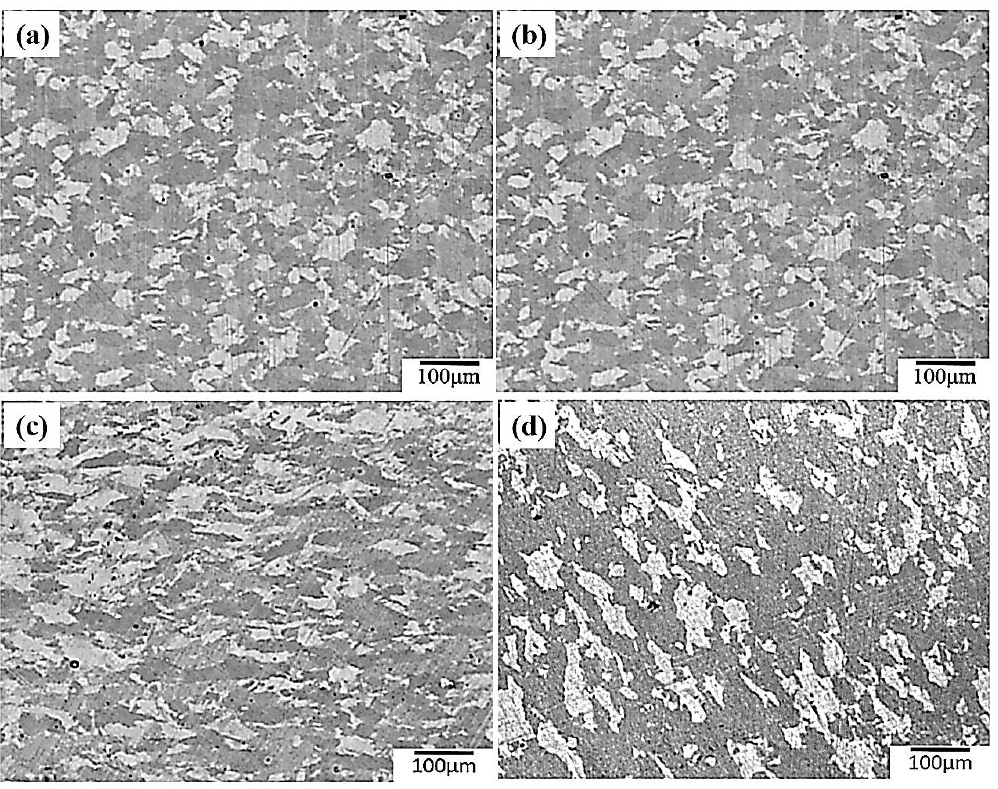
Figure 6. Microstructure of 7075 Al alloy extruded rod after various high temperature artificial aging treatments: ( a ) HTA240-8; ( b ) HTA280-6; ( c ) HTA280-12; ( d ) HTA280-18.